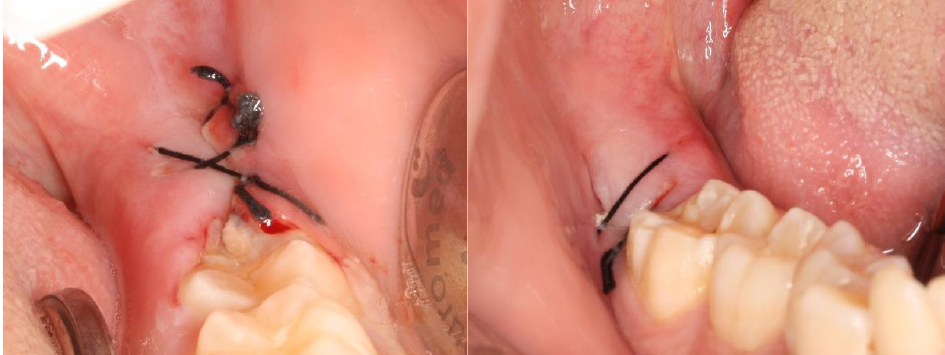
Figure 8. A case example of a patient’s follow -up, 1 week after surgery. On the left, the result of tooth extraction where chitosan was applied to the socket; on the right, the side subjected to surgery with chitosan application.